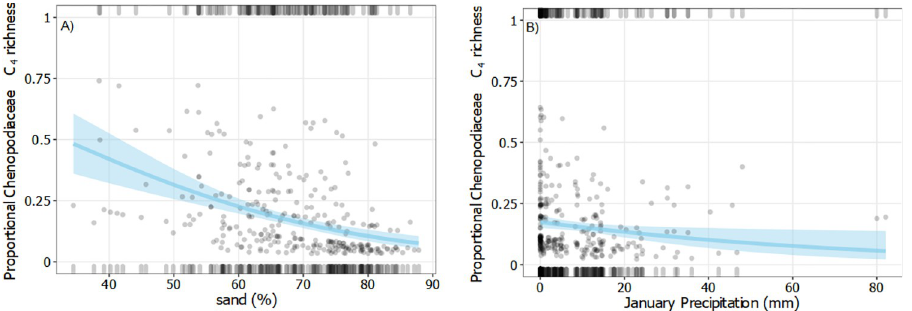
Fig 6. Binomial logistic regressions of proportional C 4 Chenopodiaceae richness. Grey points are partial residuals, blue lines and shaded bands are predicted outcomes of the regression and 95% confidence intervals respectively, and rugs were drawn to indicate observations with positive residuals (top of the plot) or negative residuals (bottom of the plot). For each plot, independent variables not depicted on the x-axis were held constant at their median value.